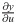
Value of activation gradients.The graph shows the average value of ∂y∂u for a particular layer during training. The fourth layer of the network (i.e. the third hidden layer), was chosen (the full network had 9 layers in total). As you can see, the gradient of y when IP is implemented is much larger than a standard network over the course of learning.